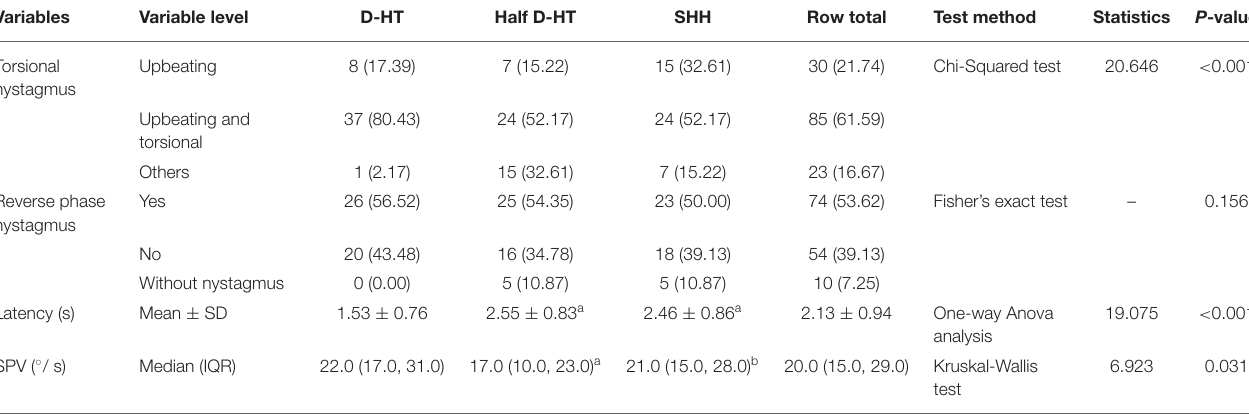
TABLE 2 | Results of three types of vertical position induction tests.